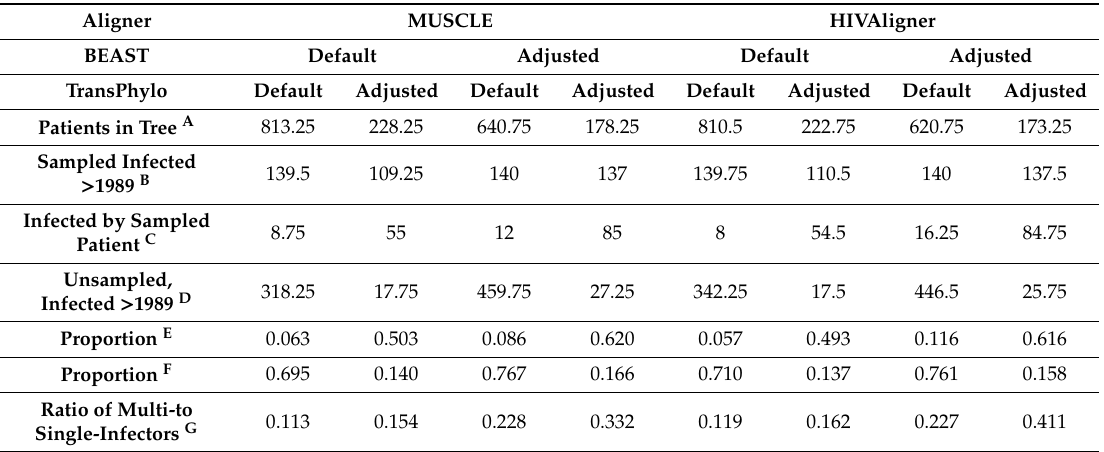
Table 3. Summary statistics describing transmission trees generated by each combination of parameters for each